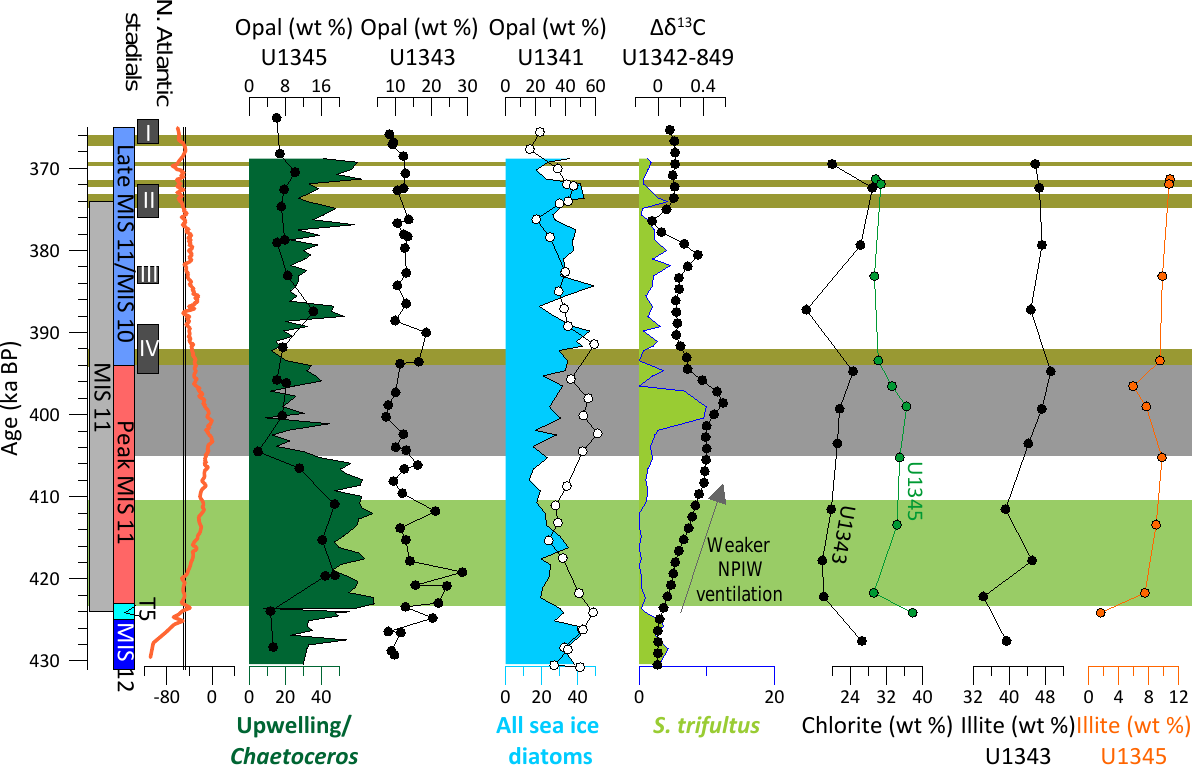
Figure 9. Comparison of Site U1345 with other Bering Sea (U1340, U1341, U1343) and global sites. The grey vertical bar depicts the duration of MIS 11, colored vertical bars refer to the zones mentioned in the text, and dark-grey bars show the timing of North Atlantic stadials (I–IV) (Voelker et al., 2010). Global eustatic sea level (orange) is plotted for reference (Rohling et al., 2010). The sill depth of Bering Strait ( − 50ma.p.s.l.) is shown as a vertical grey line. Weight% opal from sites U1345, U1343, and U1341 (Kanematsu et al., 2013) is plotted with Chaetoceros RS relative percent abundances, and relative percent abundances of all sea ice diatoms. The difference in benthic foraminiferal δ 13 C between the Bowers Ridge (U1342) and the North Pacific (ODP 849), a proxy for North Pacific Intermediate Water ventilation, is plotted with relative percent abundances of Shionodiscus trifultus , an indicator of highly stratified water. Note that ventilation increases to the left. The weight percent of the clay minerals, chlorite, and illite are plotted for sites U1343 (Kim et al., 2015) and U1345 (this study). Type I laminations are depicted as pale-green bars and type II laminations are depicted as olive-green bars. A grey bar indicates the “anomalous